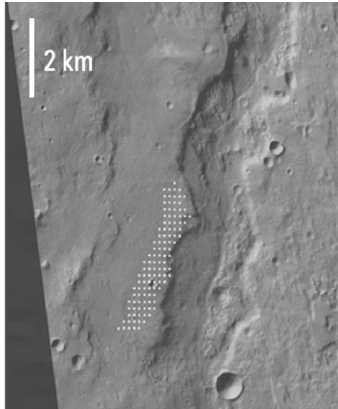
Figure 10. Mapping the identified echo on a HRSC DTM with a CTX image mapped onto it. The area of origin of the echo is materialized by the white dotted area in the center. If the echo came from the surface, it would come from the edge of a plateau.